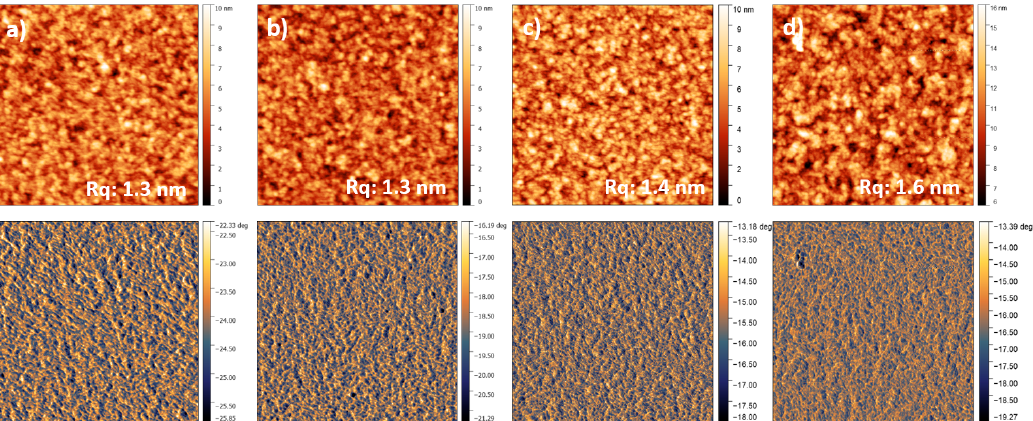
Figure 3. Representative 2 × 2 µm 2 AFM topography (upper low) and phase (lower row) images of ( a ) 3.4, ( b ) 6.8, ( c ) 13.6 and ( d ) 27.3 nM ConA adsorbed from PBS-buffer on regenerated TMSC thin films with galactomannan adsorbed recorded in air at ambient conditions.